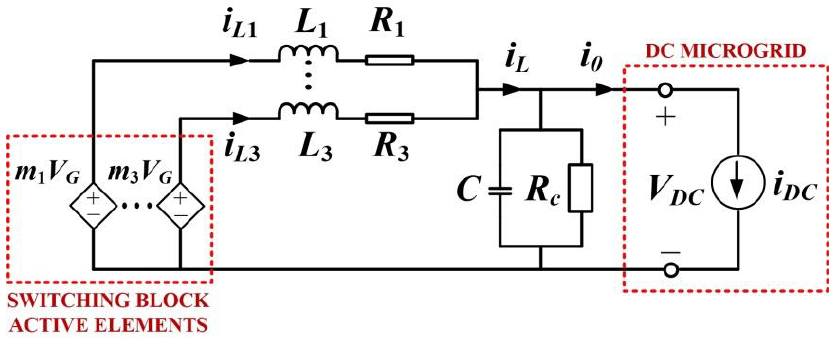
Figure 2. Equivalent block diagram of the three-phase power electronic converter.